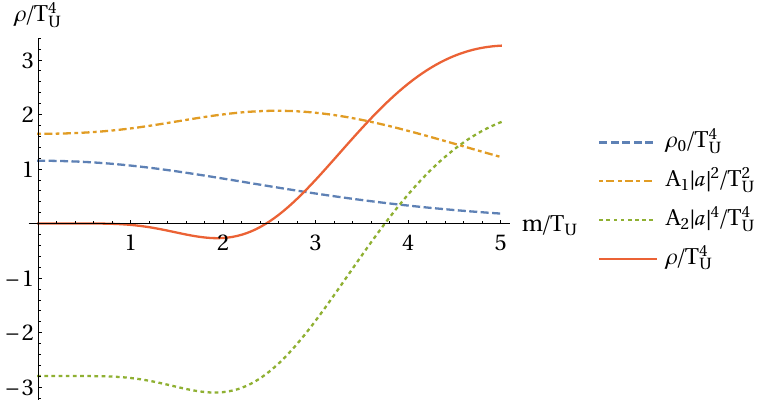
Figure 1 . Various contributions to the energy density in (7.3) at Unruh temperature and their sum as functions of